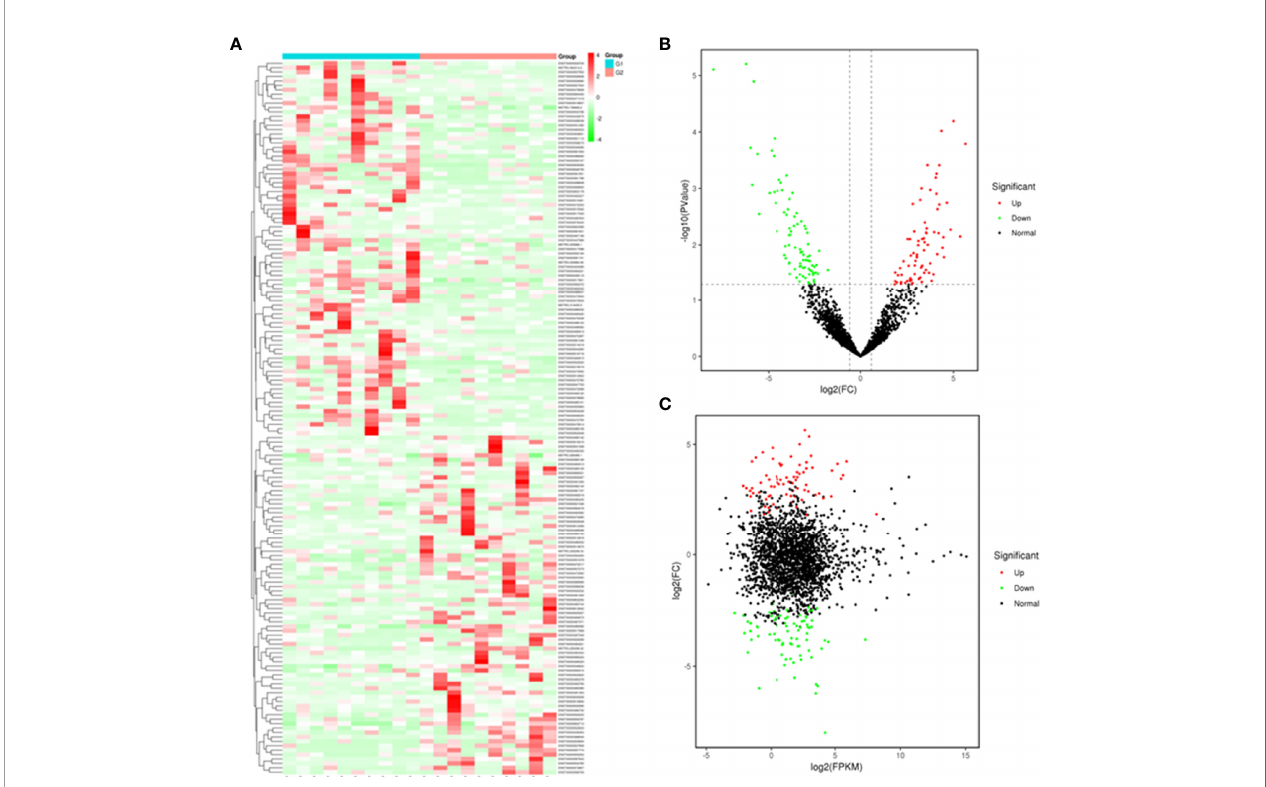
FIGURE 3 | Plasma-derived exosomal lncRNA pro fi les of case and control group. A heatmap (A) , volcano diagram (B) , and MA plot (C) of the 162 differentially expressed exosomal lncRNAs in T1DM and control subjects. G1: control group; G2: case group.